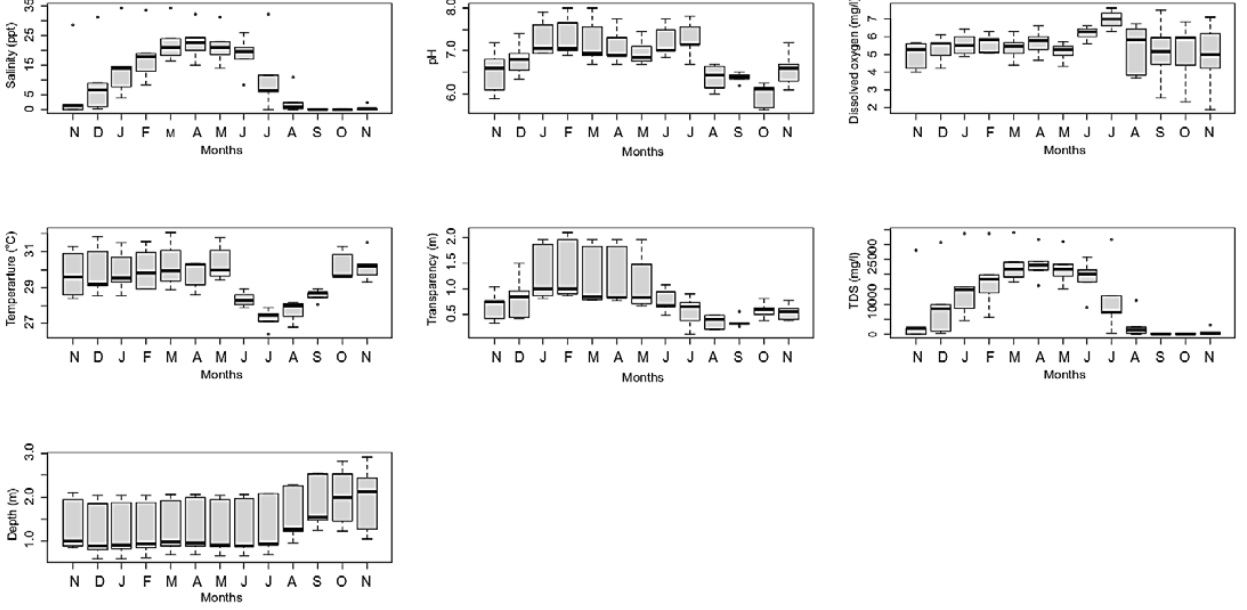
Figure 3. Seasonal fluctuation of environmental variables.